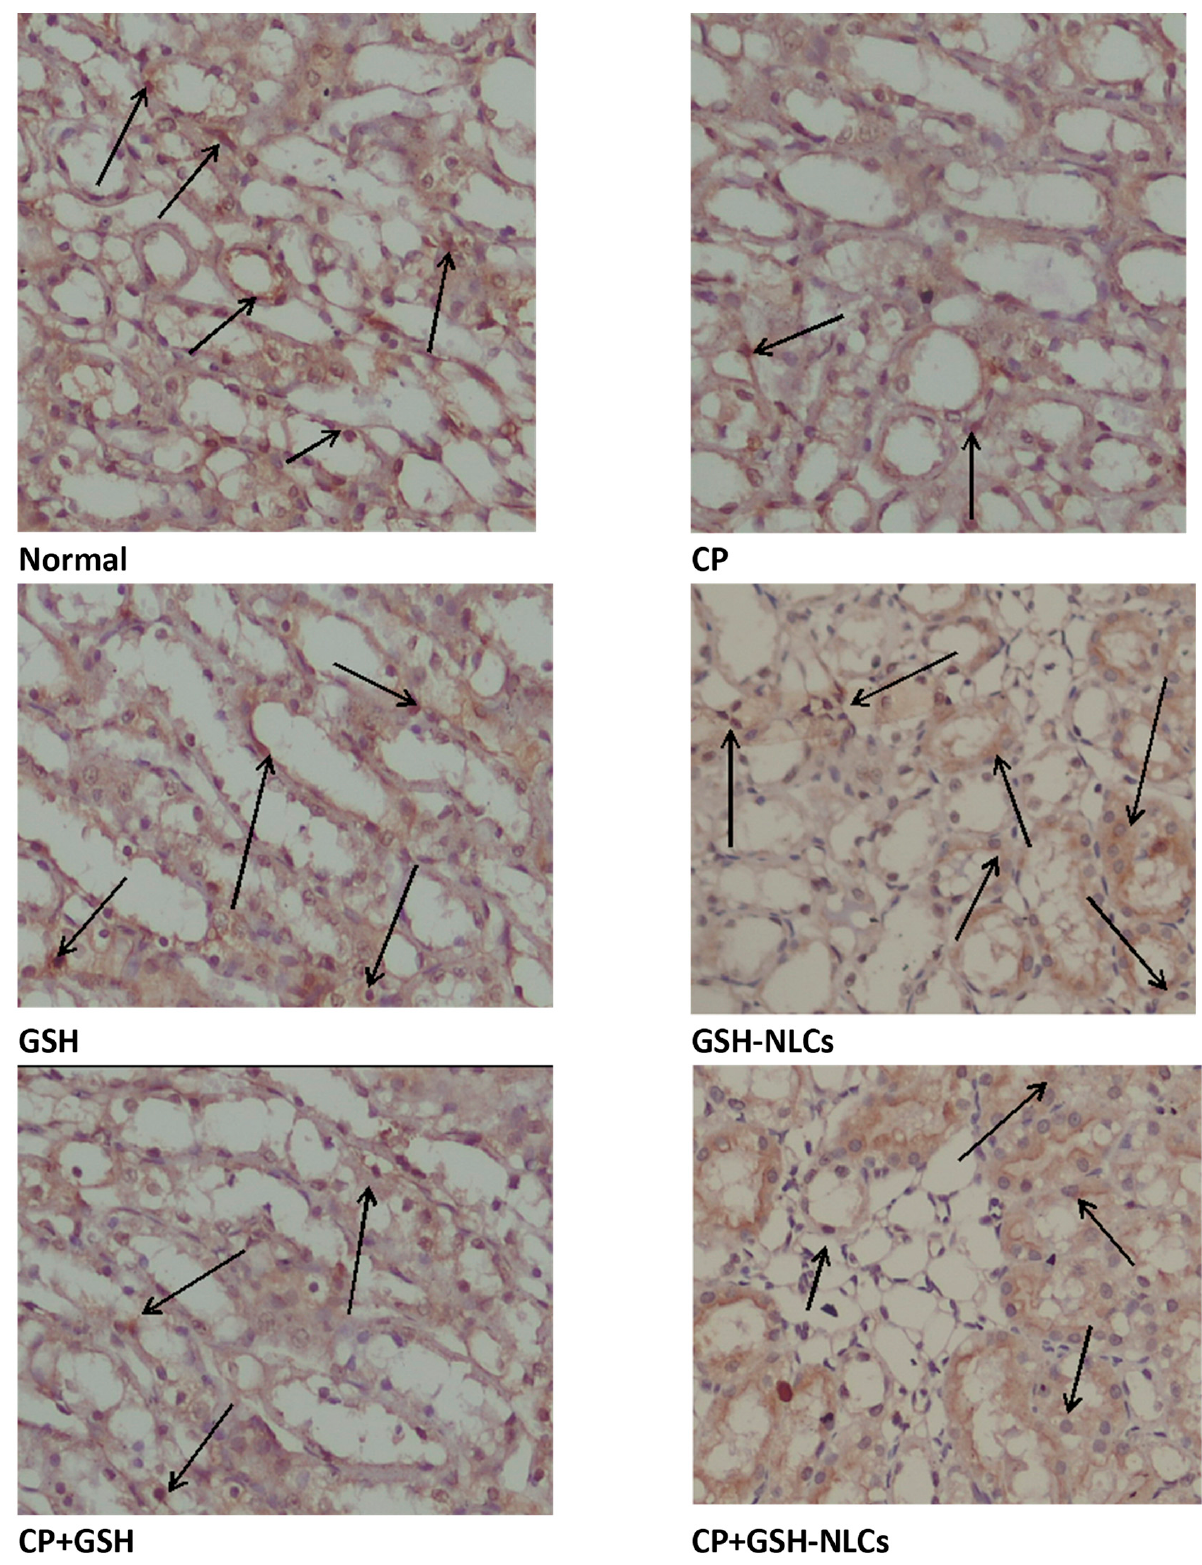
Figure 7. Immunohistochemistry results of Bcl-2 on renal tissue of Normal = Normal rats; CP = Cyclophosphamide-injured rats; GSH = glutathione-treated rats, GSH-NLCs = nano-glutathione-treated rats; CP+GSH = Cyclophosphamide + Glutathione-treated rats; CP+GSH-NLCs = Cyclophosphamide + nano-glutathione-treated rats (magnification ×200).